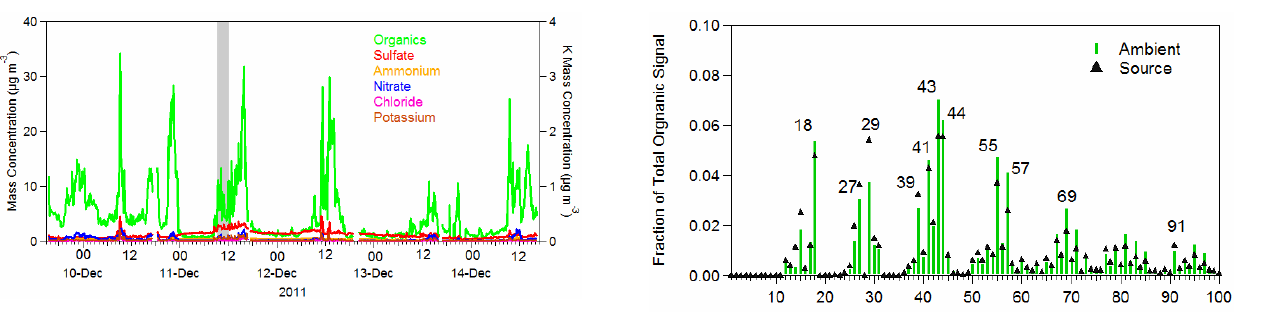
Figure 7. Example of ambient AMS measurements for December 9 th to 14 th 2011. Most Fig. 7. Example of ambient AMS measurements for 9 to 14 Decem- of the high OA periods are due to olive tree branches burning in the fields around the ber 2011. Most of the high OA periods are due to olive tree branches sampling area. The mass spectrum during 9:00-12:00 am on December 11 th (shaded area) is shown in Figure 8. burning in the fields around the sampling area. The mass spectrum during 09:00–12:00LT on 11 December (shaded area) is shown in Fig. 8.